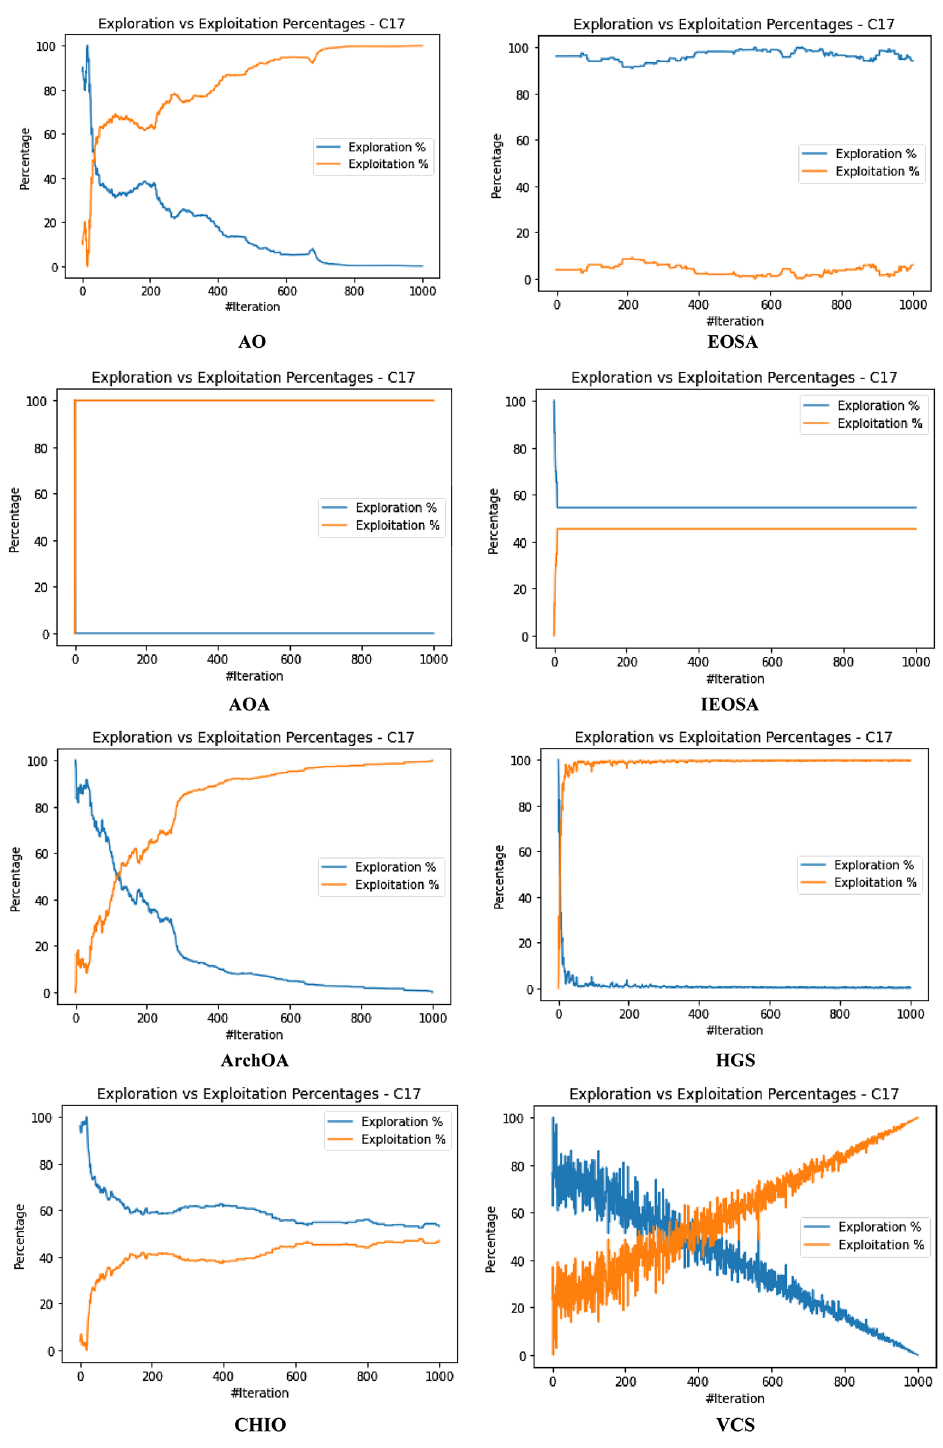
Figure 10. Illustration of the exploration and exploitation of Brown (F2) function for IEOSA as compared to AO, EOSA, AOA, ArchOA, HGS, CHIO, VCS, GA, and